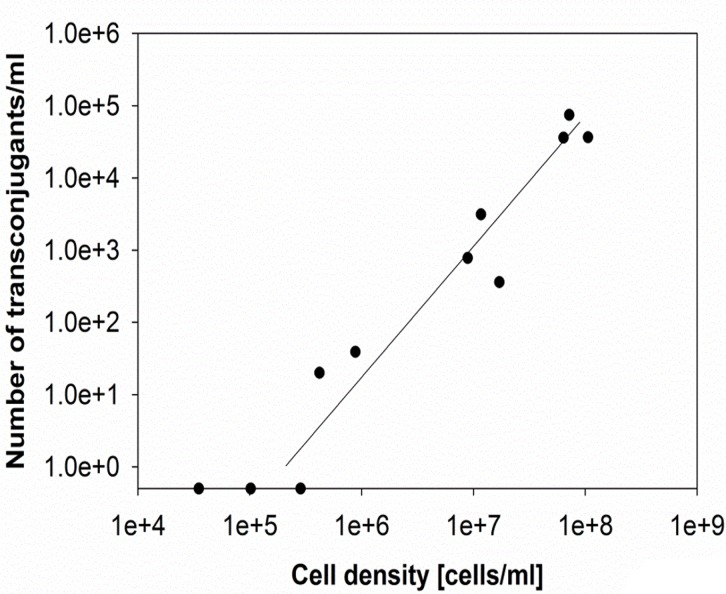
Number of evolved transconjugants/ml after co-culturing ESBL242 (donor, ampR) and E. coli MG1655 (acceptor, chlorR).Cells were mixed in a ratio of 1:1 at different total cell densities and incubated for 1 hour in batch culture.